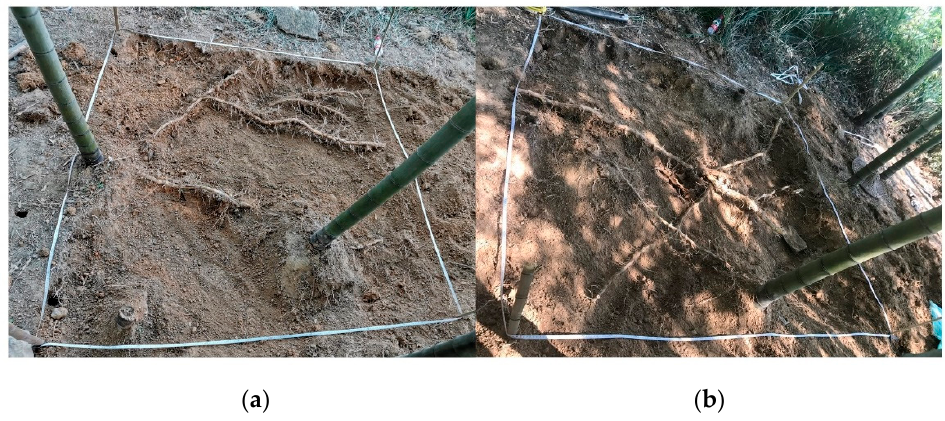
Figure 2. 3D distribution map of rhizome systems of moso bamboo excavated in the field. ( a ) Distribution map of moso bamboo rhizome system in subplot A; ( b ) Distribution map of moso bamboo rhizome system in subplot B.